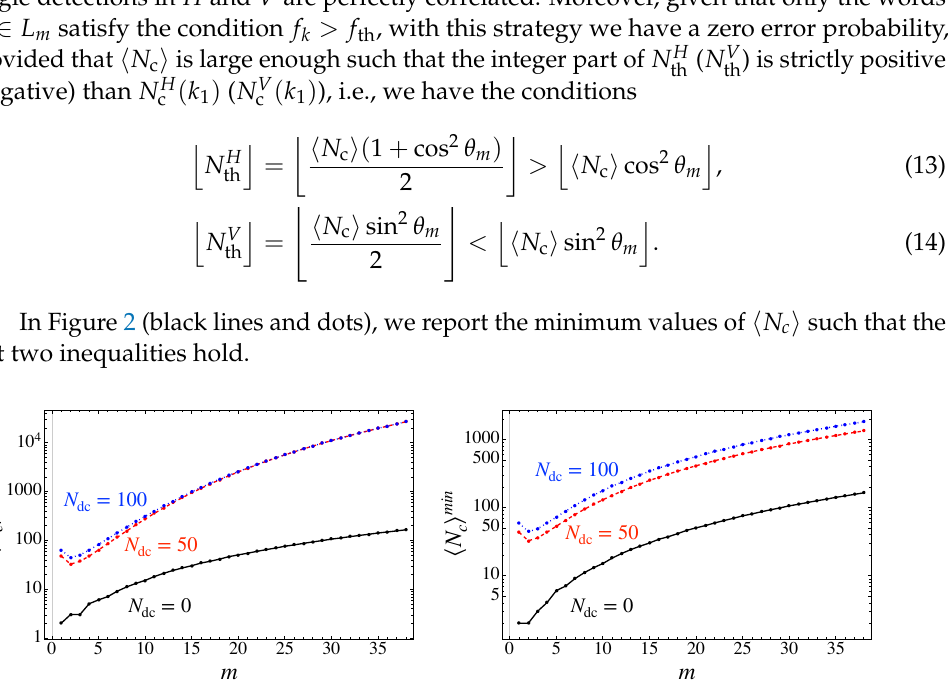
Figure 2. Black line and dots: minimum value Equation (14) ( right plot ) are satisfied as a function of m in the absence of dark counts ( N dc = 0). Red line and dots ( N dc = 50), blue line and dot ( N dc = 100): minimum vale Equation (22) ( left plot ) and Equation (23) ( right plot ) are satisfied. Notice the different scaling for the y